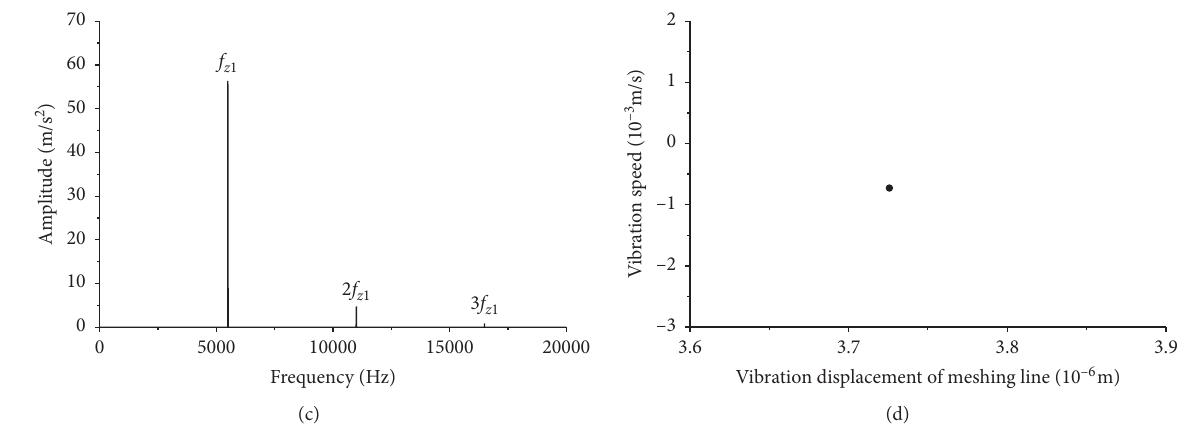
Figure 10: Vibration response of single-stage helical gear transmission system at 15,000rpm: (a) time-domain diagram, (b) phase diagram, (c) frequency-domain diagram, and (d) Poincar´e section.